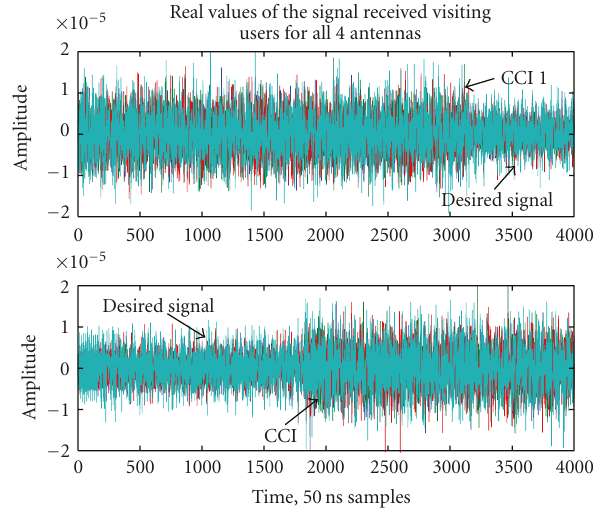
Figure 15: Typical received signal patterns in the intersystem inter- mittent interference scenario.